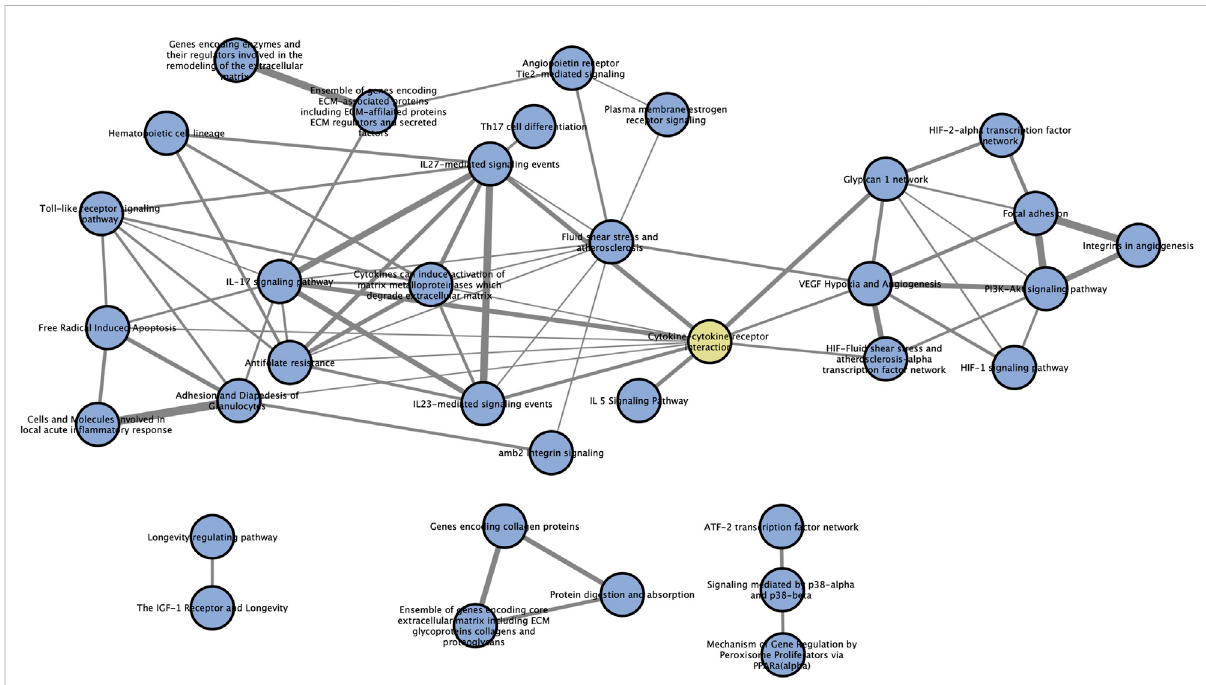
FIGURE 4 Pathway crosstalk among AMDgset-enriched pathways. Nodes denote pathways while edges represent crosstalk between pathways. The yellow node represents “ cytokine-cytokine receptor interaction ” pathway which acts as the joint of two main modules. The width of edges is depended on the score of speci fi c pathway pair, wider edge indicates stronger